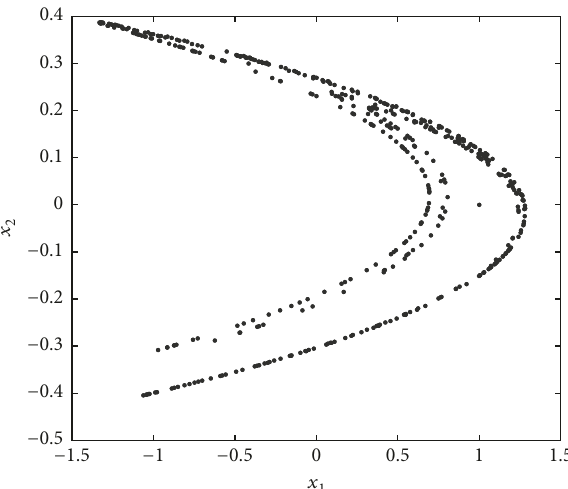
x 1 (0) = 𝑥 (0) = 0 1 2